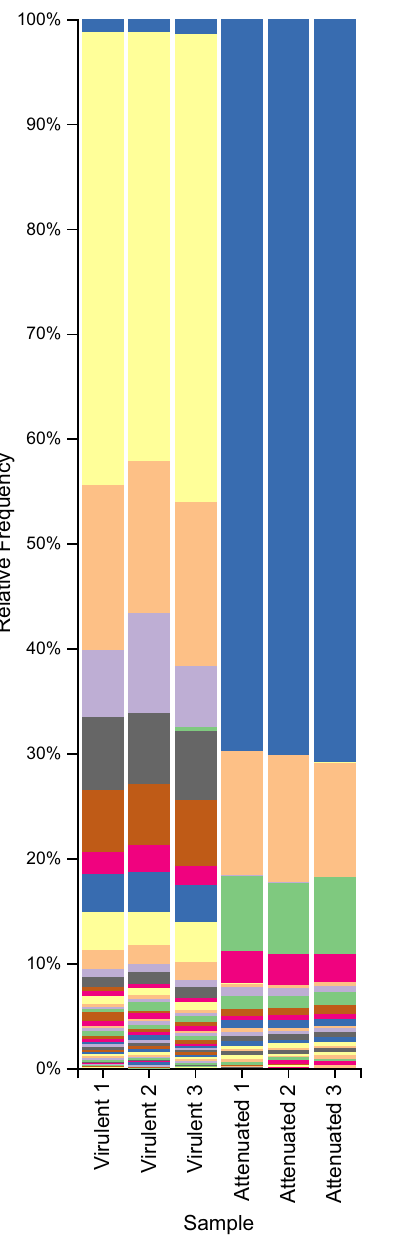
Figure 2. Relative abundance of the prokaryotic community in the attenuated and virulent cultures by 16S rRNA gene